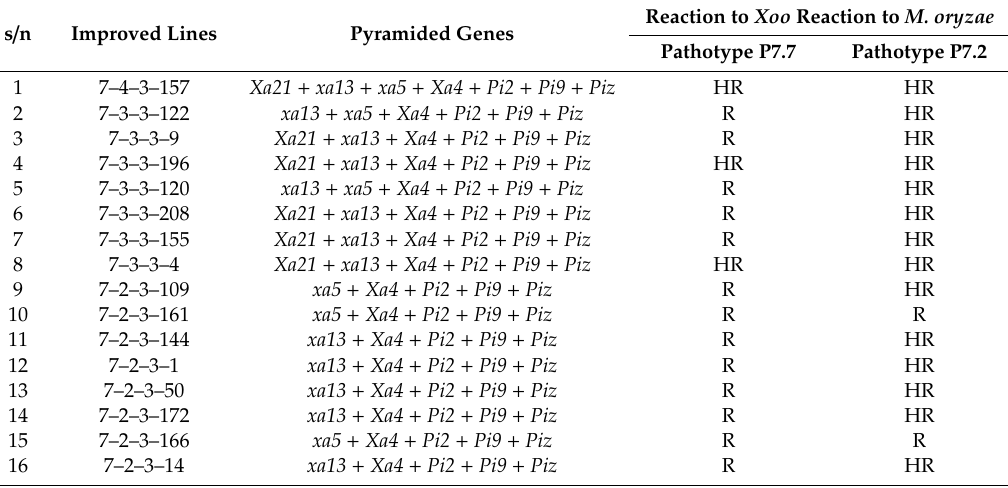
Table 3. Genetic composition of BC 2 F 2 selected lines pyramided with multiple R-genes for broad spectrum and durable